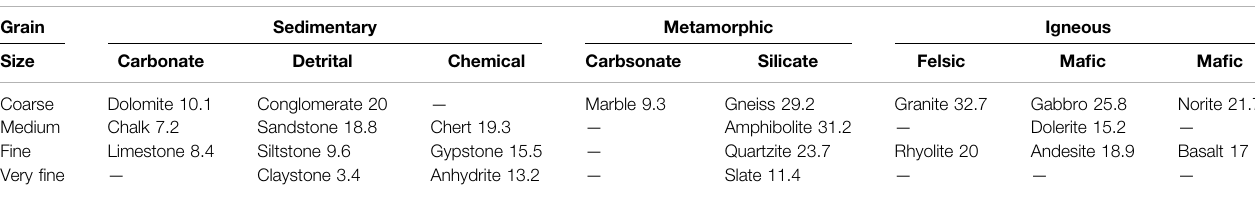
TABLE 2 | Values of constant m i for intact rock, by rock